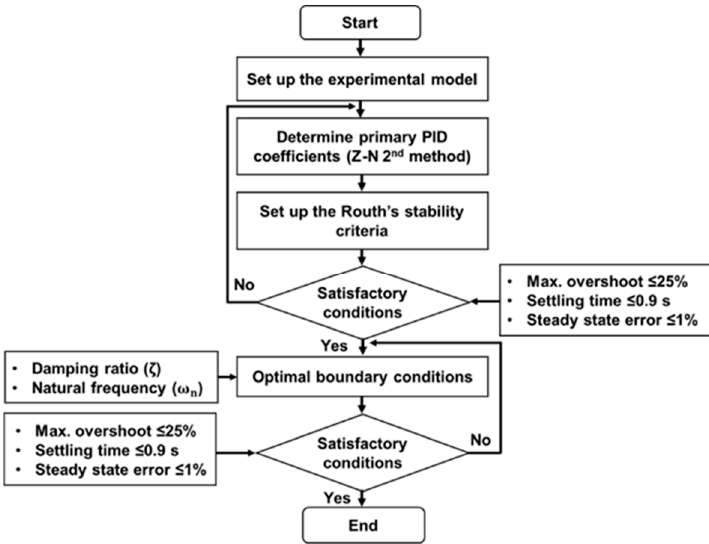
Figure 6. The boundary conditions of the control algorithms considering and without considering viscosity.